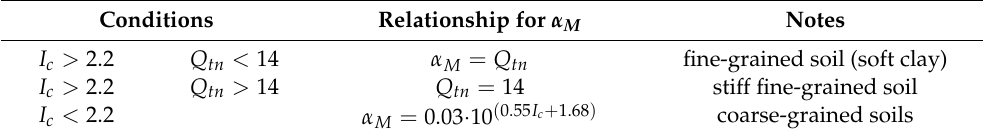
Table 6. Constrained modulus factor α M , as defined by